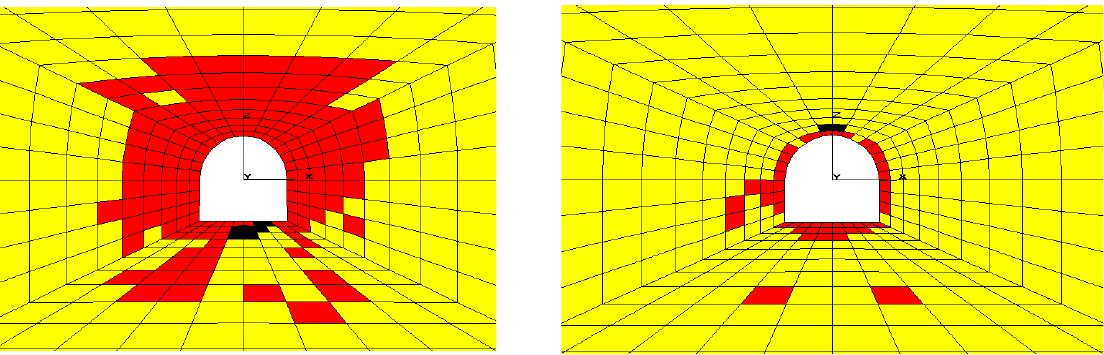
Figure 14. The plastic yield zone of roadway surrounding rock at an excavation length of 12 m